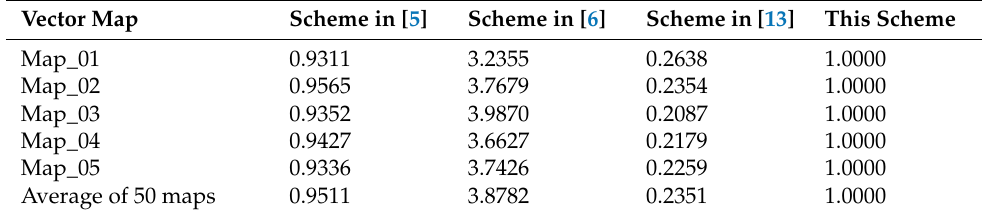
Table 9. Comparison results of watermark capacity among different schemes (bit/vertex). Vector